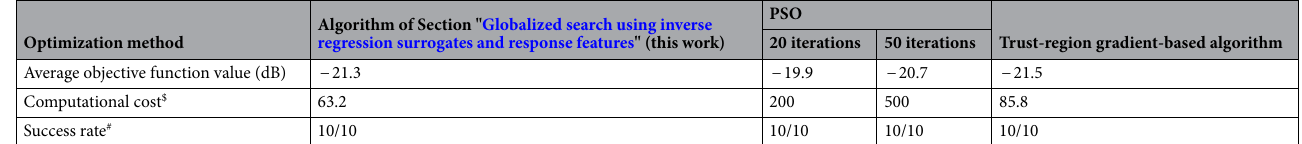
Table 4. Optimization results for Structure III. $ The cost calculated as the number of EM simulations of the structure under design, averaged over ten algorithm runs. # Number of algorithms runs with the operating